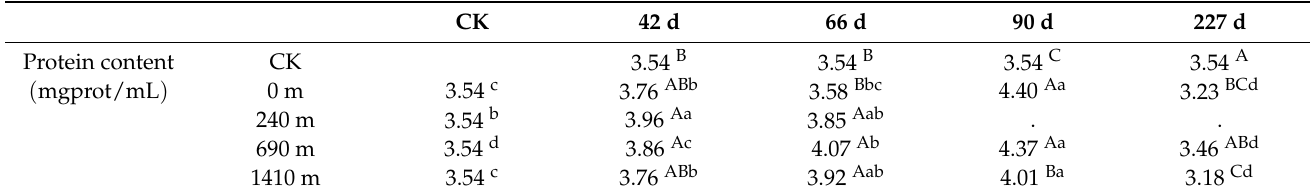
Table 3. Other notable parameters.